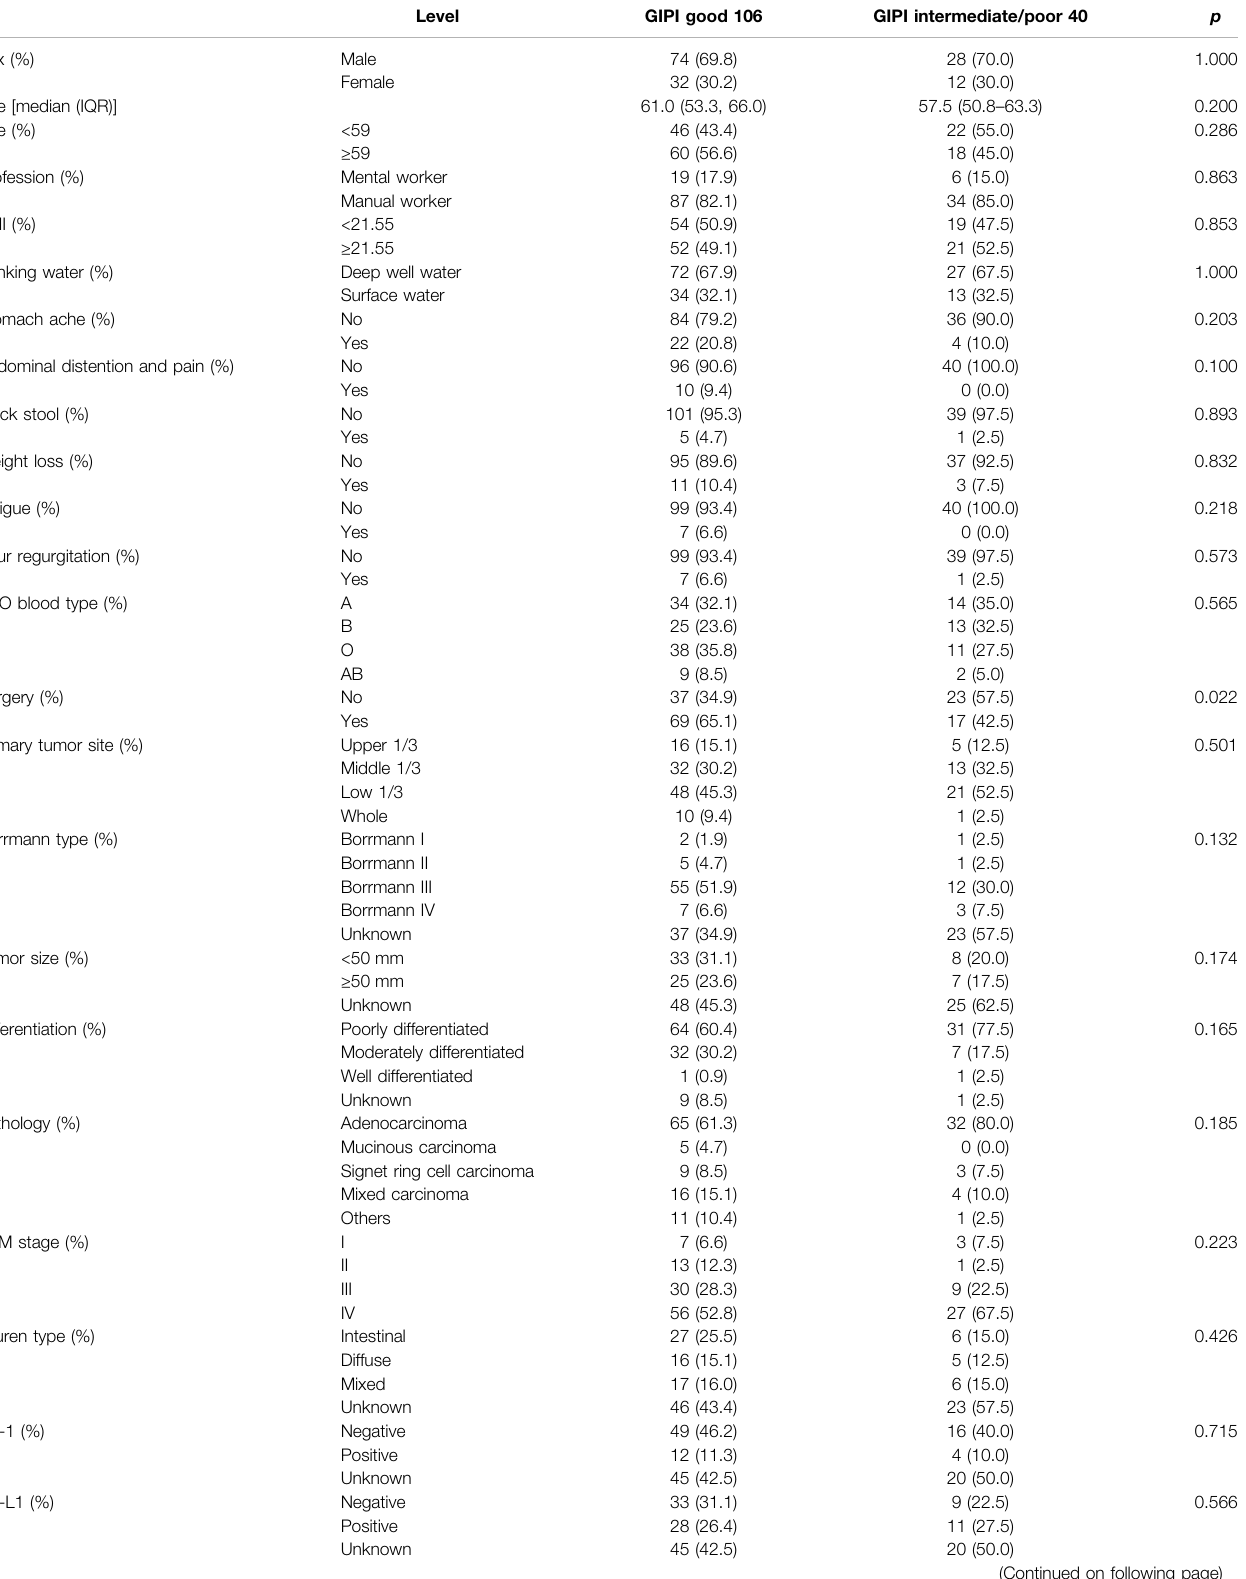
TABLE 1 | The clinical characteristics of all enrolled